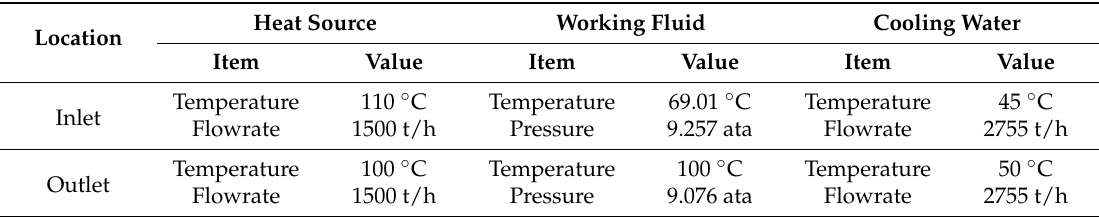
Table 7. Design conditions of organic Rankine cycle.